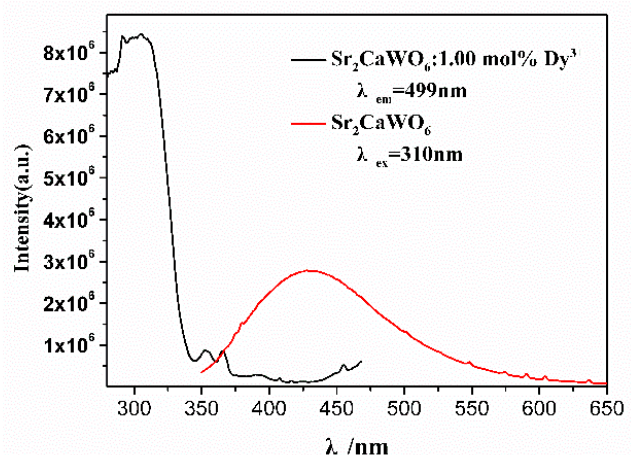
Figure 6. The excitation spectrum of Sr 2 Ca 0.985 WO 6 : 1 mol% Dy 3+ ( λ em = 499 nm) is shown in black, and the emission spectrum of Sr 2 CaWO 6 under 310 nm excitation is shown in red.